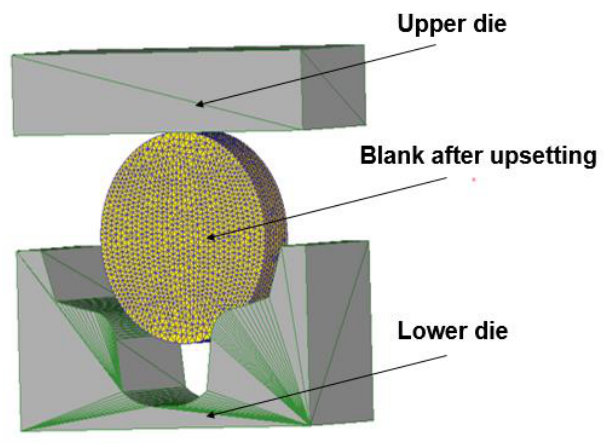
Figure 13. Simulation analysis figure of T-shaped blank.